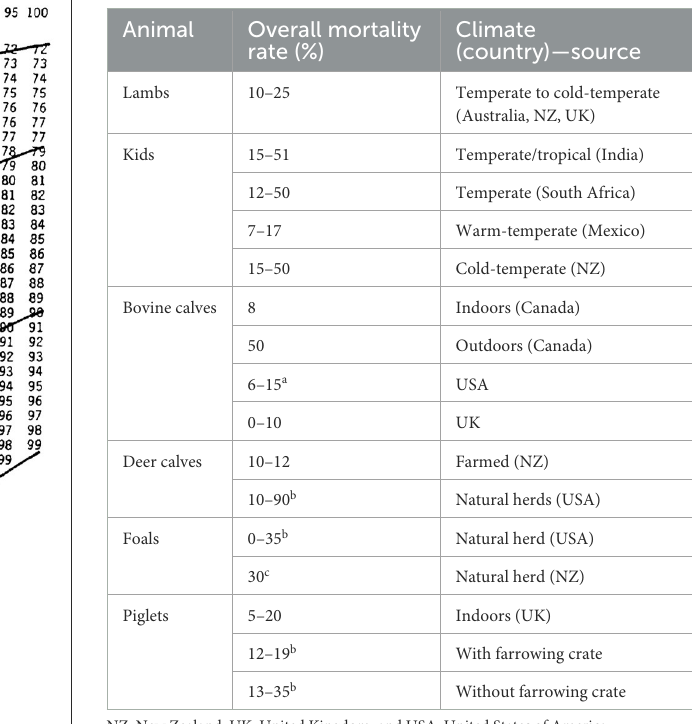
TABLE 1 Neonatal mortality rates in different farm animals in different